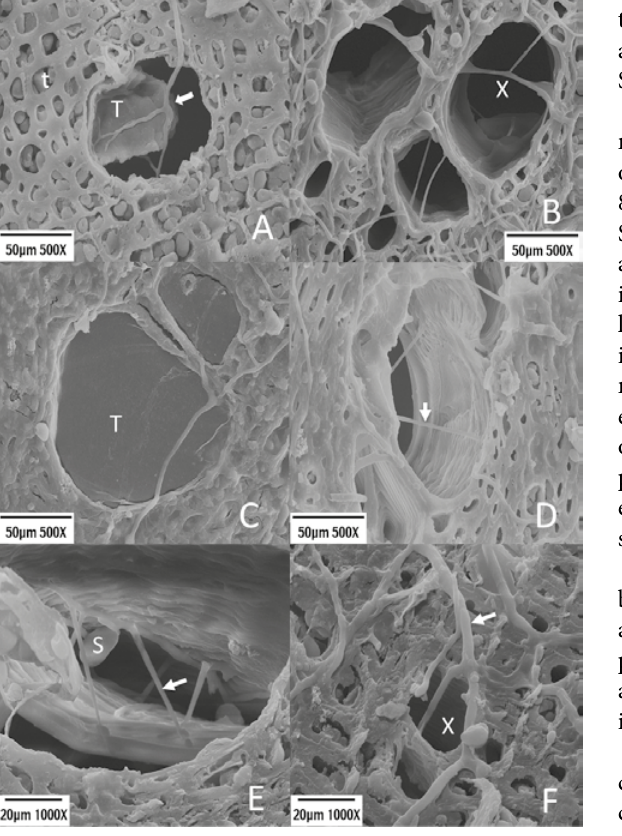
Figure 9. SEM cross-sections of grapevine stems inoculated with pycnidiospores of Lasiodiplodia gilaniensis (A and B), Diplodia seriata (C and D) or D. corticola (E and F), at 48 h after inocula- tion. A, tylosis formation in a xylem vessel, and hyphae entering the vessel. B, hyphae entering a xylem vessel. A large amount of myce- lium is present. C, hyphal entrance blocked by a tylosis. D, hyphae entering xylem vessels, using pits as anchoring sites for colonization of the xylem vessel cell walls (arrow). E, pycnidiospore inside a tra- chea, colonizing a xylem vessel and using the pits as anchor sites. The cell wall is not damaged. D, hyphae entering a xylem vessel. Arrows indicate hyphae. X) xylem vessel; T) tyloses; t) tracheids; S)